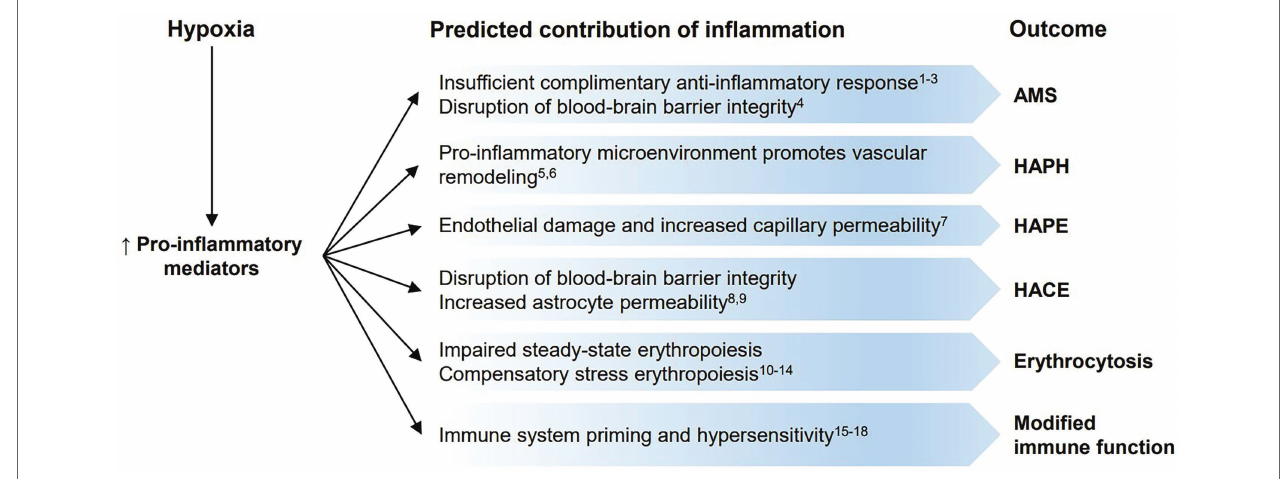
FIGURE 2 | Predicted contributions of inflammation to high-altitude illnesses, erythrocytosis, and immune function. Hypoxic conditions lead to increases in pro- inflammatory mediators, which may play a role in the development of high-altitude illnesses [(Acute Mountain Sickness (AMS), high-altitude pulmonary hypertension (HAPH), high-altitude pulmonary edema (HAPE), and high-altitude cerebral edema (HACE)] and erythrocytosis, or modify immune function. (1) Julian et al. (2011); (2) Liu et al. (2017); (3) Wang et al. (2018); (4) Varatharaj and Galea (2017); (5) Wilkins et al. (2015); (6) Brito et al. (2020); (7) Mishra et al. (2016); (8) Song et al. (2016); (9) Zhou et al. (2017); (10) Jackson et al. (2010); (11) Liao et al. (2018); (12) Bennett et al. (2019); (13) Imagawa et al. (1990); (14) Haase (2013); (15) Kvamme et al. (2013); (16) Baze et al. (2011); (17) Facco et al. (2005); and (18) Feuerecker et al.